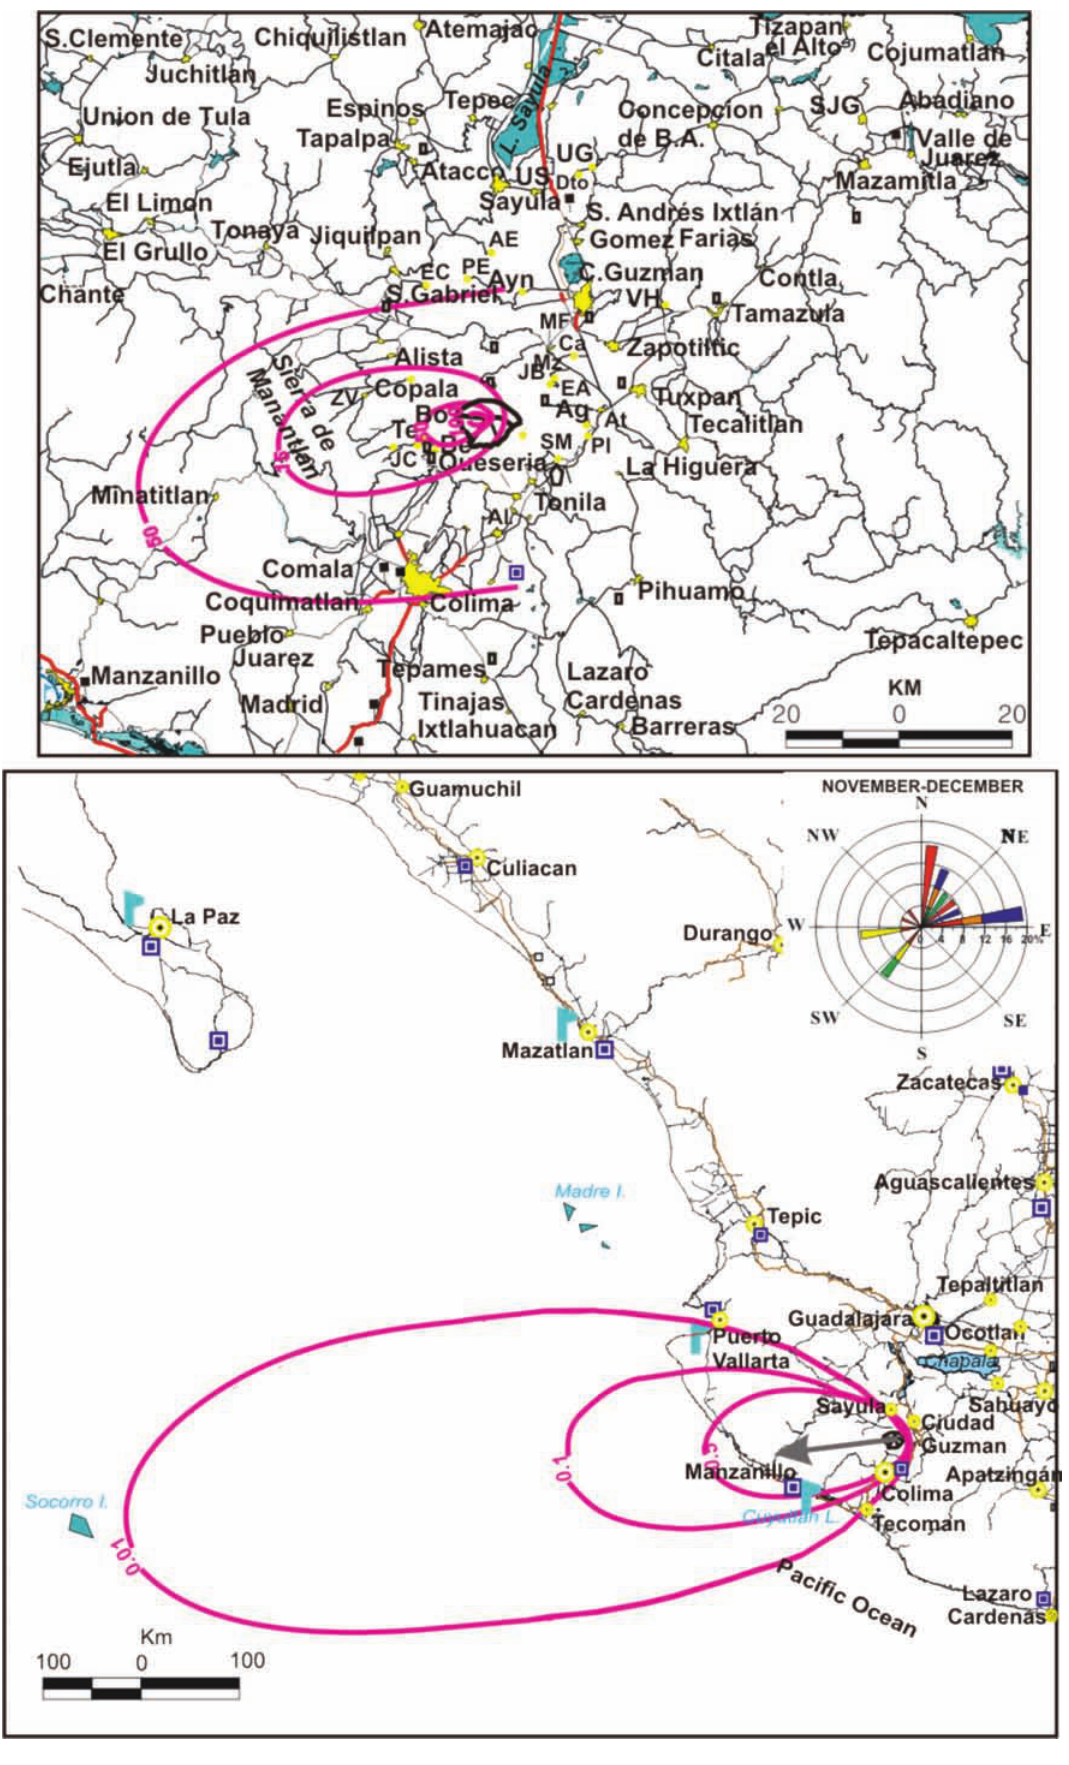
Figure 10. Scenario 7. For an eruption in November or December, showing the west-southwest area and the Pacific Coast that would be affected by a future Plinian eruption. For details, see legend to Figure